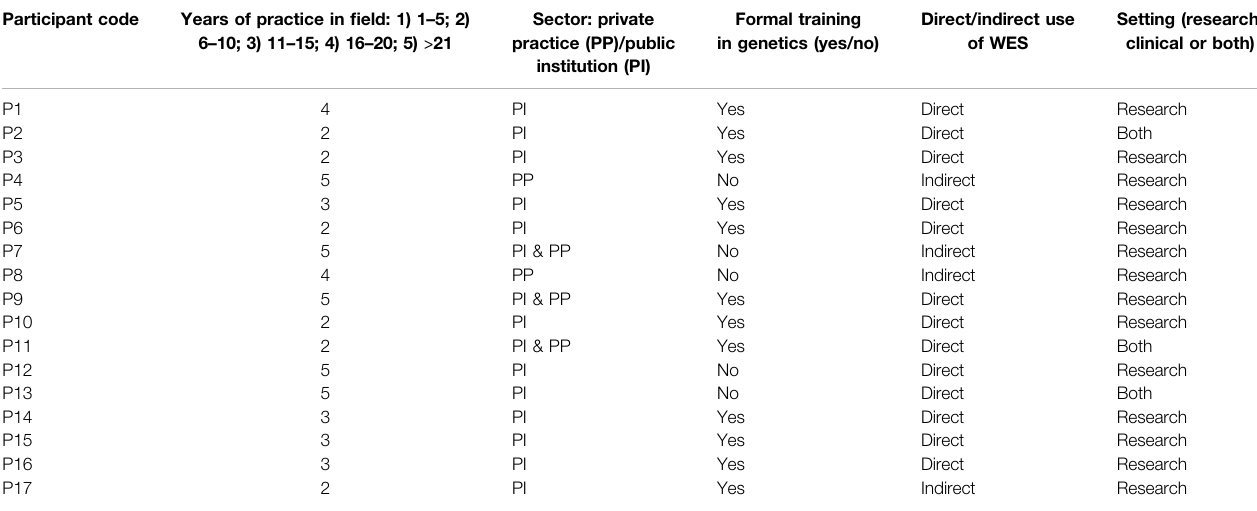
TABLE 2 | Demographics of the study participants. Participant code